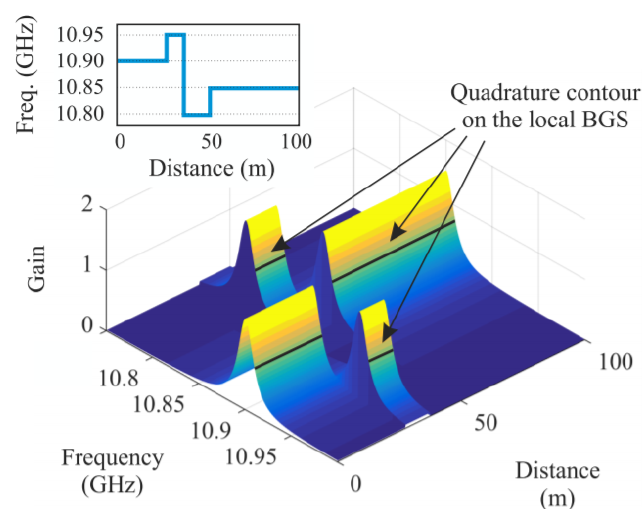
Figure 8. Fast changing the probe frequency allows the latter to lie within the slope of each local BGS, even in case of spatial nonuniformities [55].